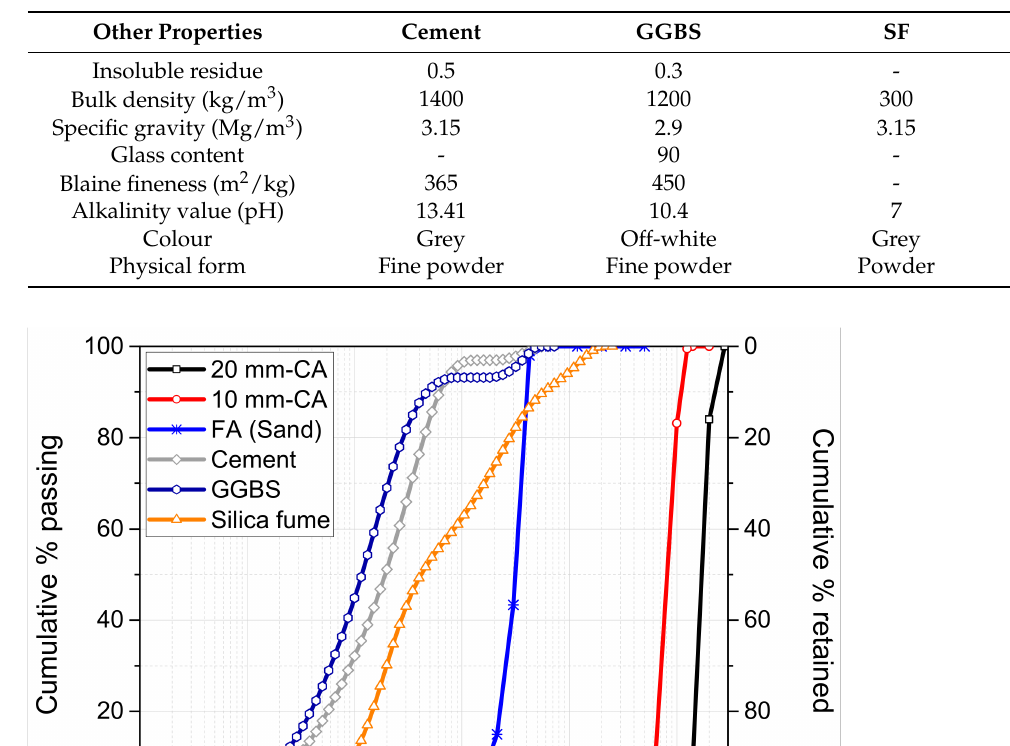
Table 2. Physical compositions of OPC, GGBS, and SF.